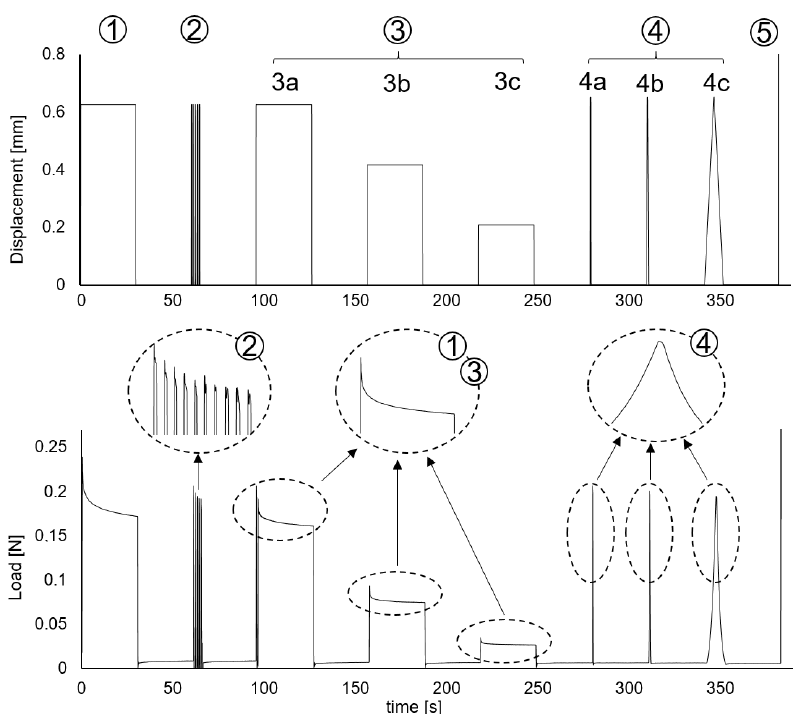
Figure 2. Imposed displacements in the different test stages and reaction force of the PSBV for specimen 2632A/20. The stages with constant displacement have been enlarged to show the decrease in force in stages (1) to (3), and the concavity of the load–discharge curve of stage (4). Stages (1) and (3) are stages with constant strain: the first one up to the established strain level ε max , and the second one divided in three stages up to ε max , 2/3 · ε max